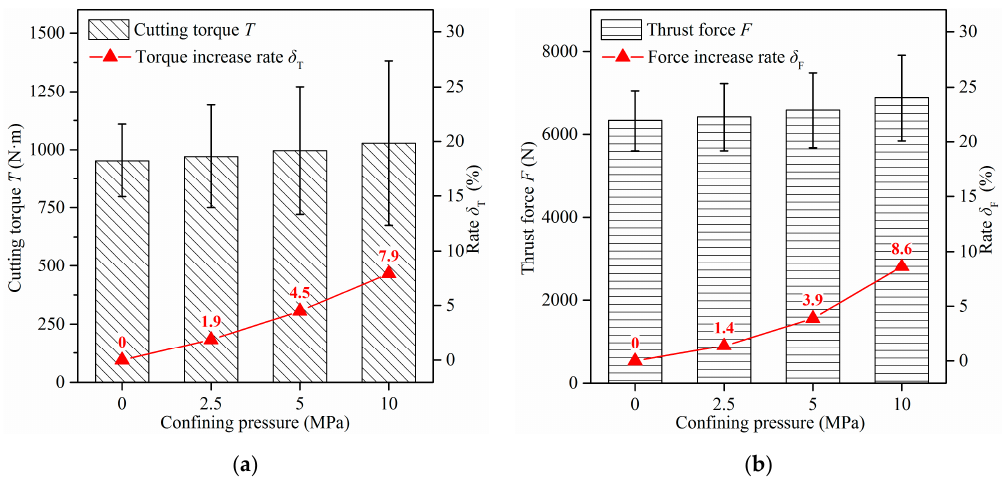
Figure 25. Effect of confining pressure on ( a ) cutting torque and ( b ) thrust force of the rock containing five holes.